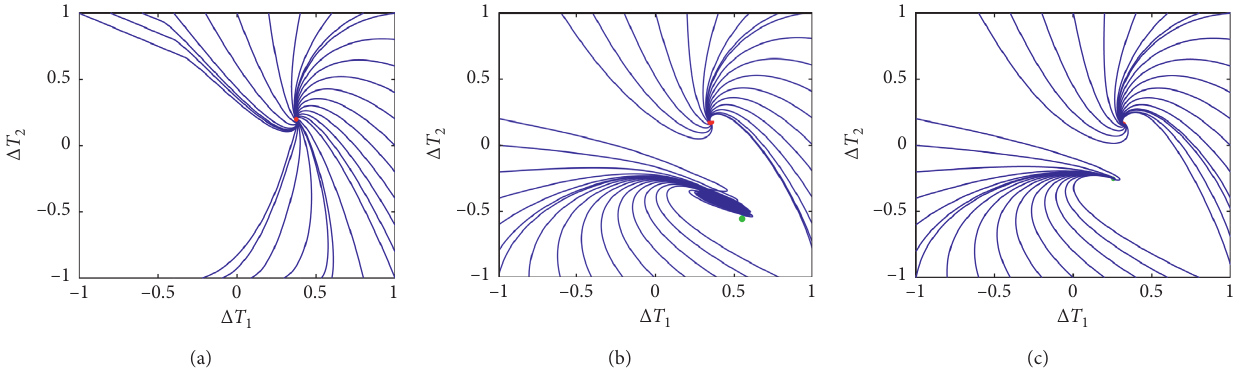
Figure 12: Phase portraits for different height ratios as k �− 0.5. (a) α � 0.5. (b) α � 1.1. (c) α � 2.